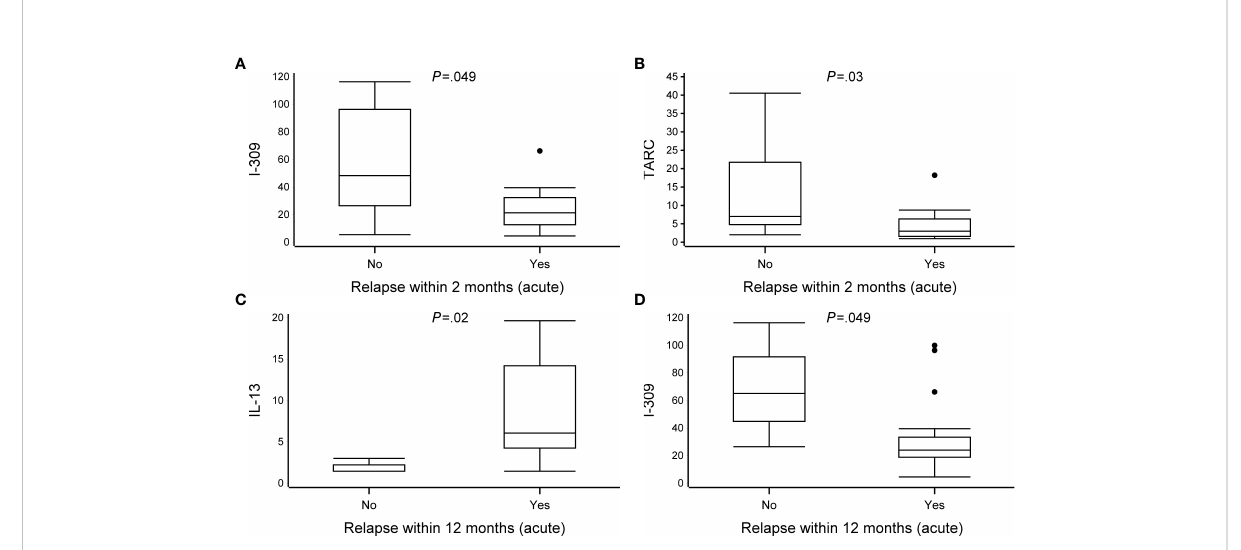
FIGURE 3 The association between cytokine expression and recurrences at 2 and 12 months. Data are presented as median [the lower (Q1) and upper (Q3) quartiles, and data falling outside the Q1 – Q3 range are plotted as outliers]. Cytokine concentrations are presented as pg/ml. Due to scarcity of the occurrence of relapses in the RSV group, only patients from the RV group were included in the analyses. In the association between cytokine expression and recurrences at 2 and 12 months, multiple signi fi cant differences were observed between virus groups (relapse vs. no-relapse, all P <.05) (A – D) . An analysis of difference was excluded due to the small number of patients in the no-relapse group (n = 3). All data are shown in Supplementary Table